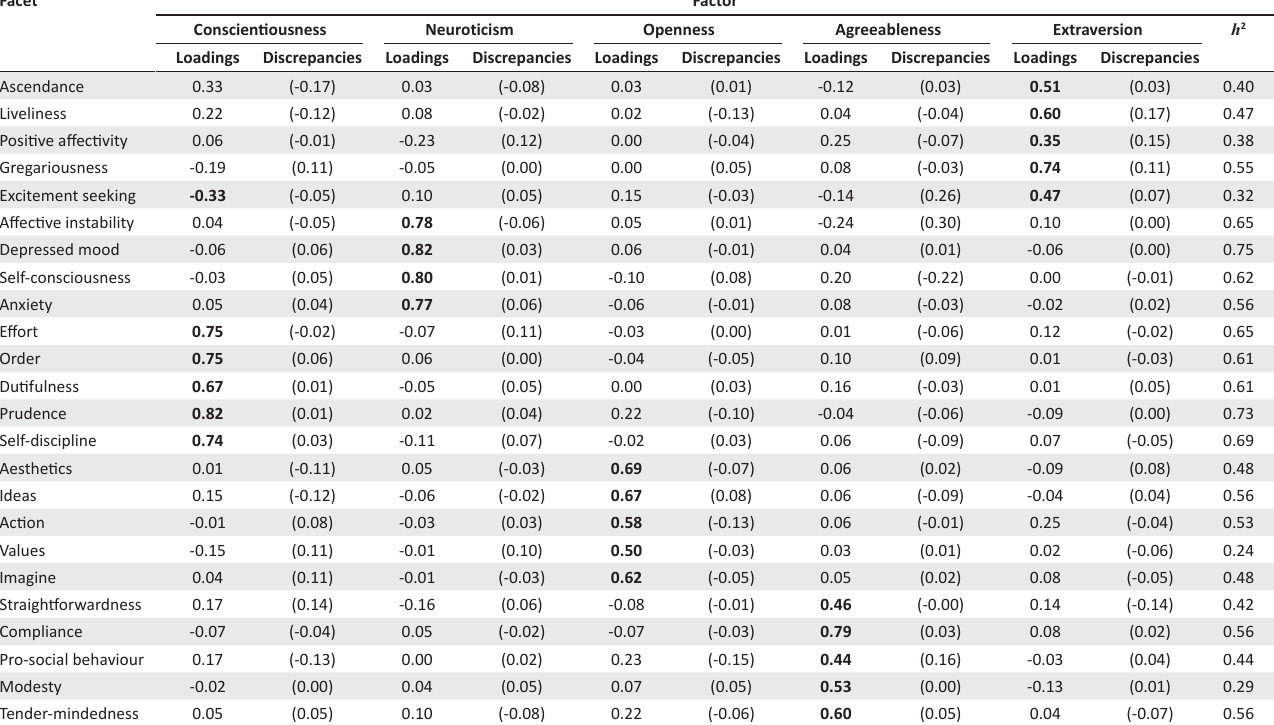
TABLE 2: Oblique target rotated factor pattern matrix of the 24 Basic Traits Inventory facets for the pooled adolescent group. Facet